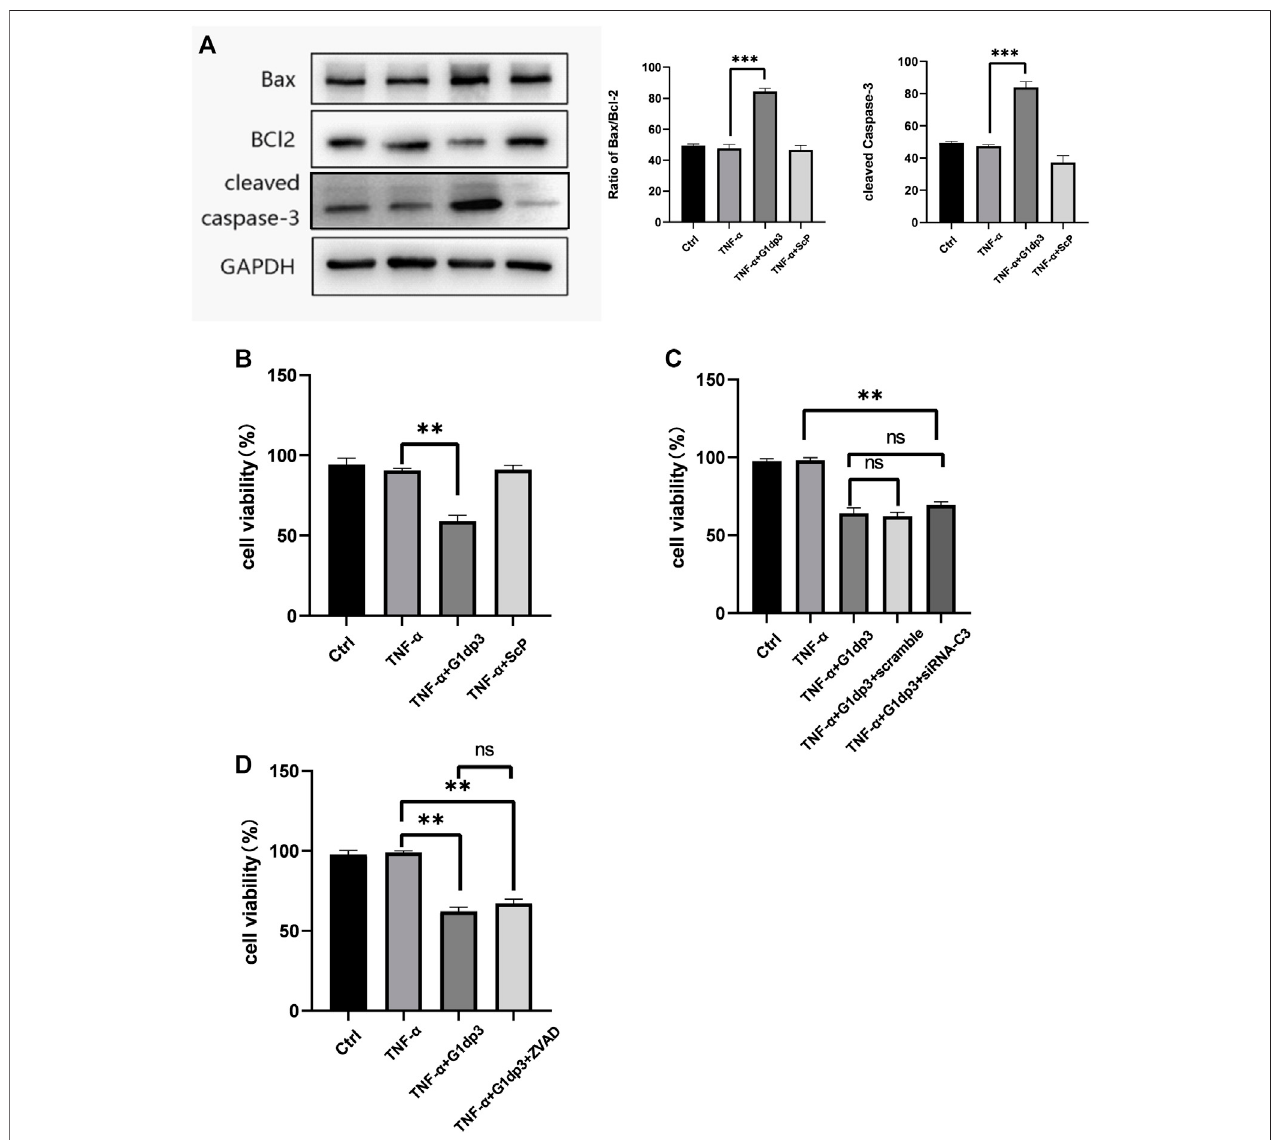
FIGURE 1 | G1dP3 inhibits MH7A cell viability independent of apoptosis. (A) The protein levels of Bax, cleaved-caspase-3 and Bcl-2. G1dP3 (20 μ M, 6 h) dramatically increased the expression of Bax and cleaved-caspase-3, while decreased that of Bcl-2. (B) Cell viability was detected in the indicated MH7A cells. MH7A cell viability was inhibited by G1dP3 (20 μ M, 6 h). (C,D) The inhibition of G1dP3 in MH7A cell viability could not be reversed by siRNA-Caspase3 (20 μ M) or pre- treated z-VAD-fmk (30 μ M, 24 h). Graph represents mean ± SD; * p < 0.05, ** p < 0.01, *** p < 0.001, ns, not signi fi cant. Representative data from one of three individual